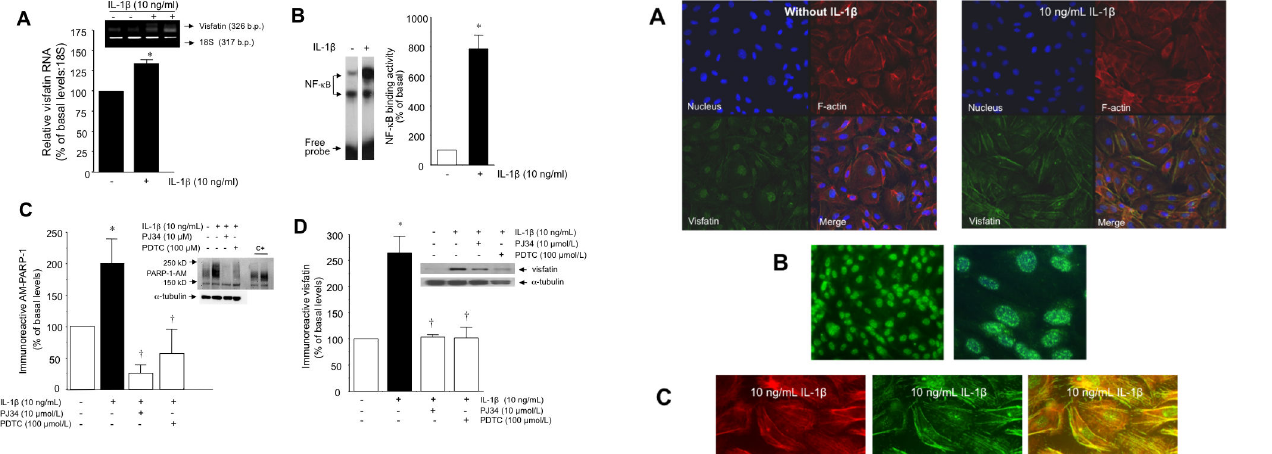
Figure 2. The sequential activation of NF-κB and PARP-1 activation mediates inflammation-evoked visfatin production. (A) Relative mRNA expression of visfatin in HUVEC treated with or without IL-1β (10 ng/mL; 18 h). (B) NF- κB activation in HUVEC after incubation with IL-1β (10 ng/mL) for 1 h was determined by EMSA. Data are the mean±SEM of four independent experiments. * P <0.05 vs basal levels. (C) Auto-modified immunoreactive PARP-1 in HUVEC stimulated for 18 with or without IL-1β (10 ng/mL; 18 h), in the absence or presence of the respective PARP-1 and NF-κB inhibitors PJ34 (10 µmol/L) and PDTC (100 µmol/L). Data are the mean±SEM of four independent experiments. * P <0.05 vs basal; † P <0.05 vs IL-1β. (D) Visfatin protein levels in HUVEC treated with IL-1β (10 µmol/L; 18 h) with or without PJ34 (10 µmol/L) or PDTC (100 µmol/L). Data are the mean±SEM of four independent experiments. * P <0.05 vs basal; † P <0.05 vs IL-1β. Representative gels are shown.